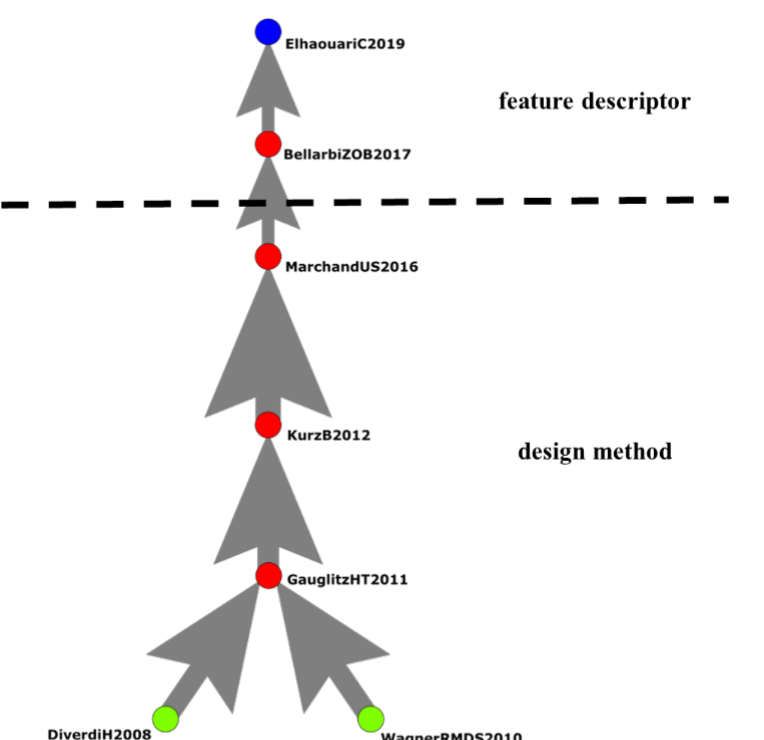
Figure 9. Application of AR technology in architecture.